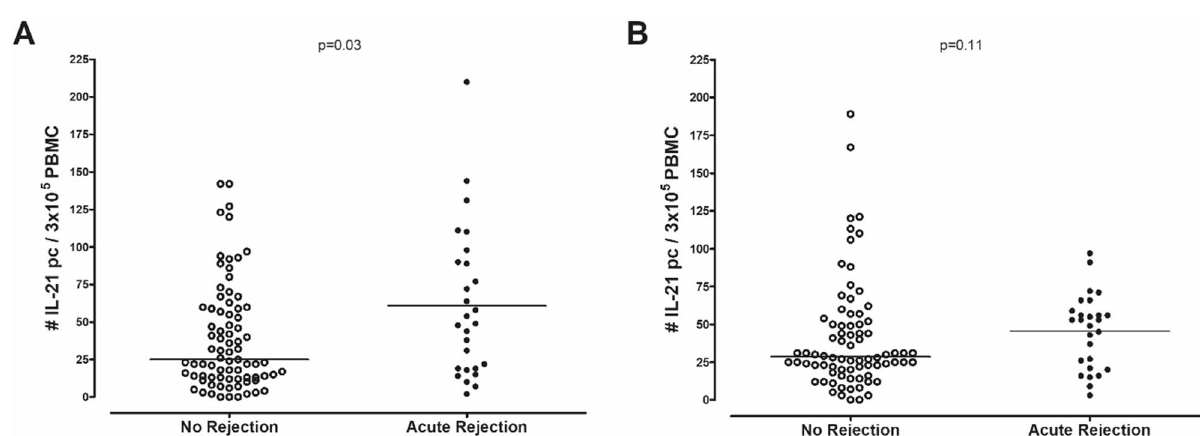
Figure 2. Number of donor-reactive IL-21 producing cells ( A ) and third party-reactive IL-21 producing cells ( B ) in n = 84 patients with no rejection and n = 30 patients with acute